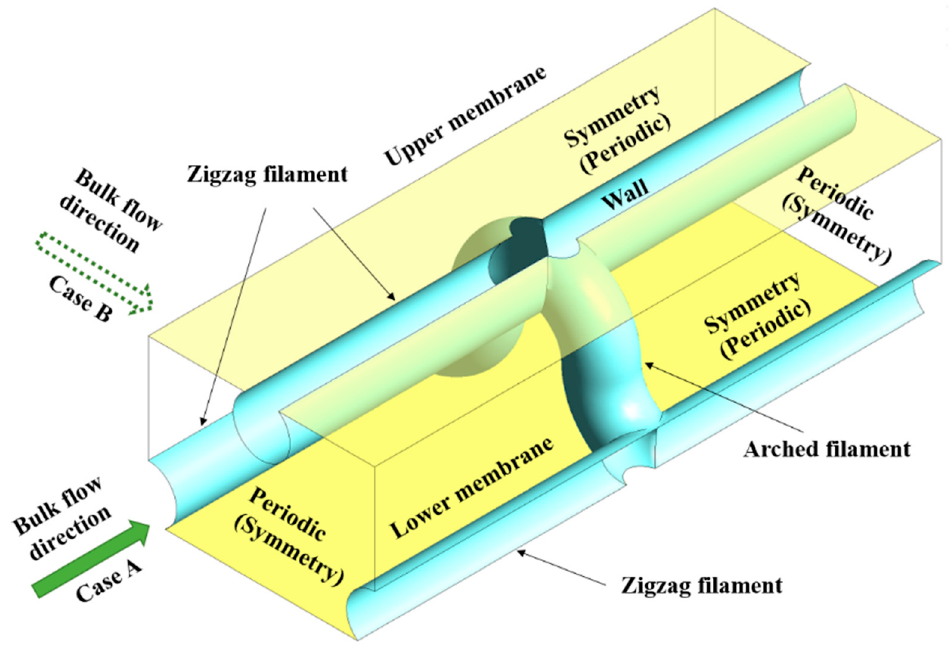
Figure 3. CFD (computational fluid dynamics) model setting.